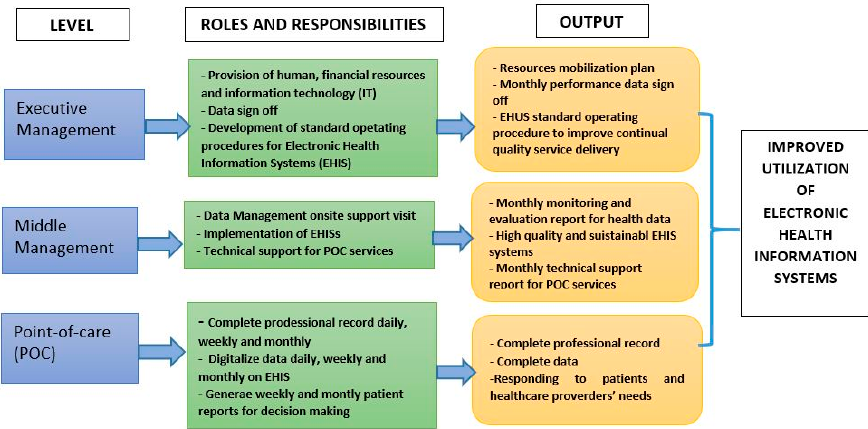
Figure 2. Proposed roles and responsibilities of stakeholders to ensure efficient utility of electronic health information systems for disease diagnosis and treatment at point-of-care in low and middle income counties.